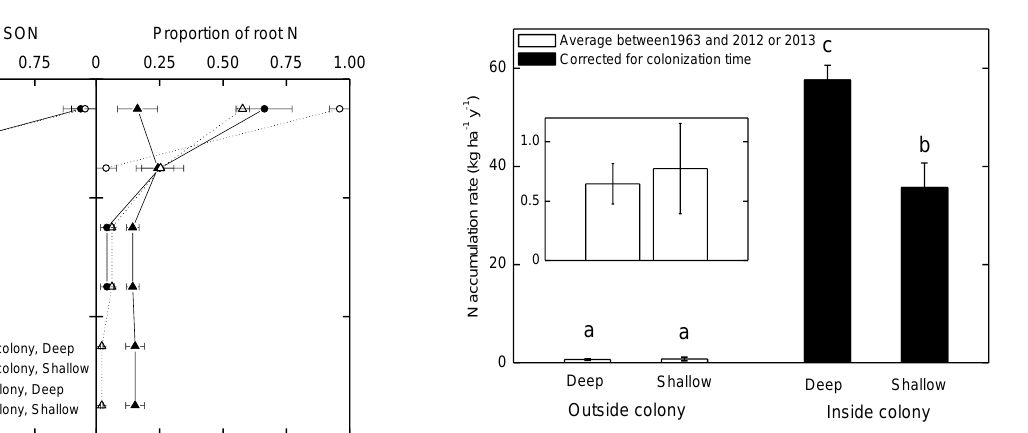
Figure 3. Depth distribution of soil organic nitrogen (SON) and root N in four ecosystem types on Surtsey. Mean ( ± SE) proportions at each depth layer were calculated relative to the total SON or root N content in the top 30cm. Statistical results can be found in Table 2.